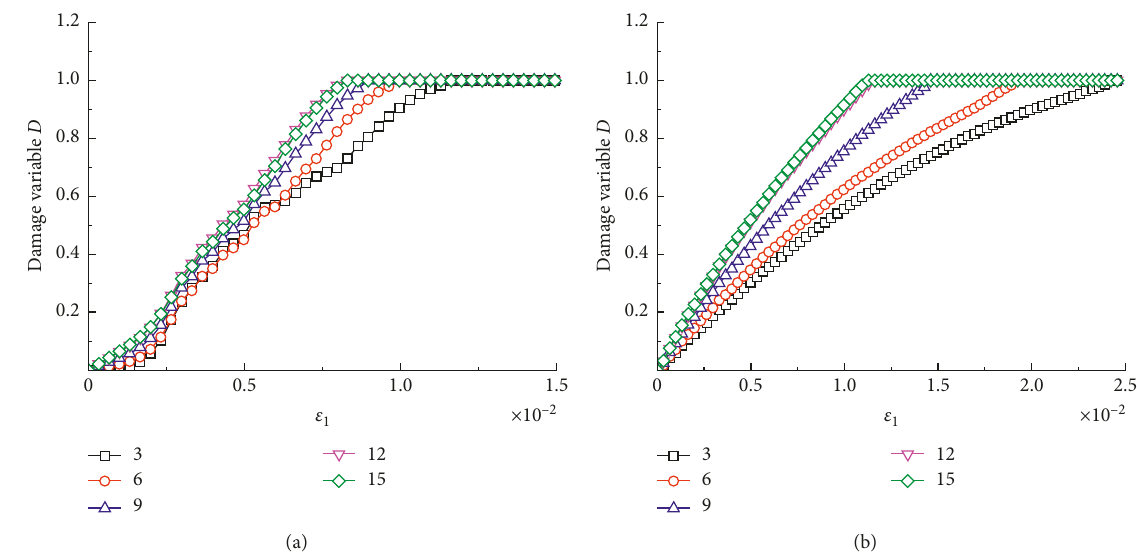
Figure 7: Damage variable under different dry-wet cycles: